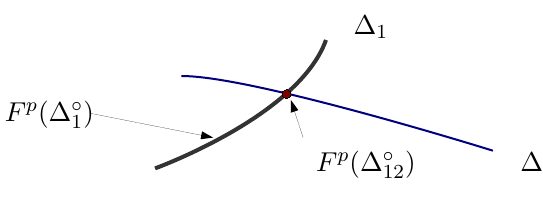
Figure 6 . Association of a limiting F p to the points on the discriminant